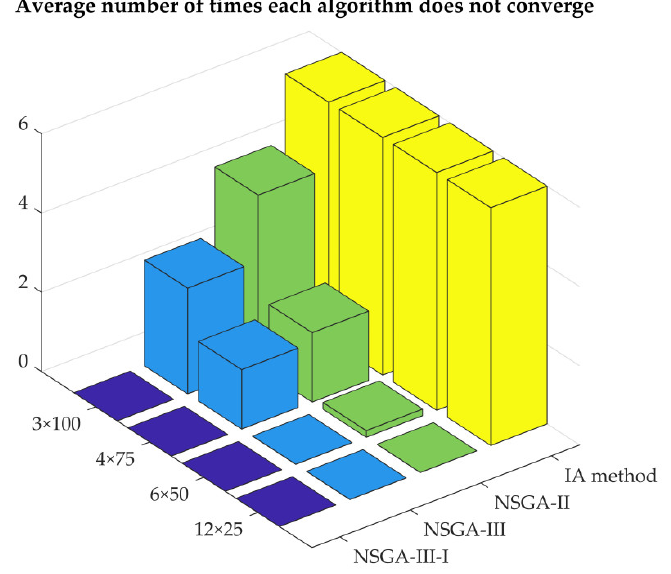
Figure 15. The average number comparison of non-convergence times of different methods in the same batch of experiments.